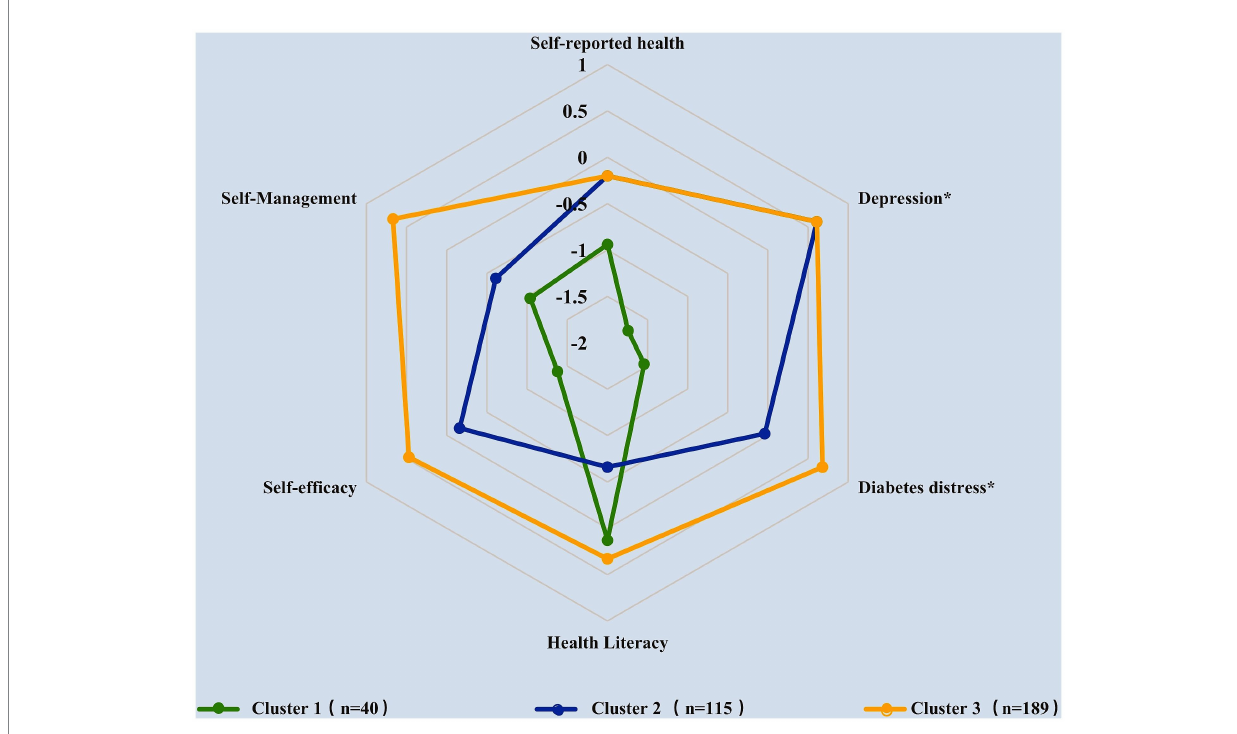
FIGURE 1 Description of elderly, multimorbid patients with diabetes clusters according to the median of standardized scores for each variable (*the z -scores of diabetes distress and depression variables were